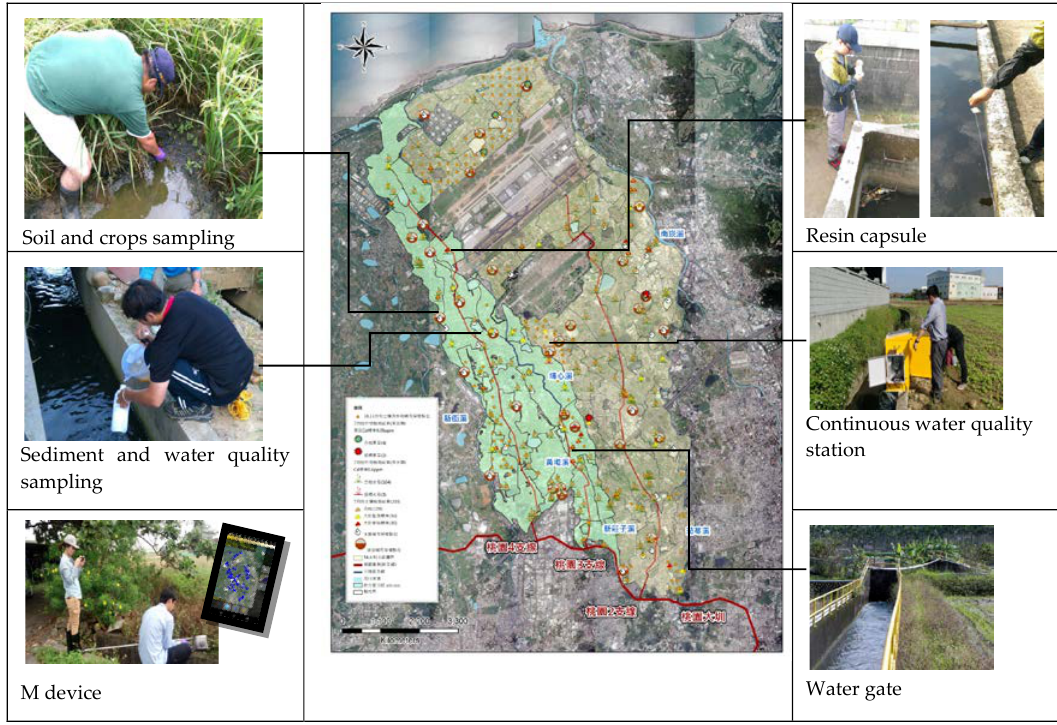
Figure 5. Map of monitoring stations, samples, and locations of water gates within the current agricultural environment protection system, along with the relative contamination risk of different areas in the pilot area (green low, yellow medium).